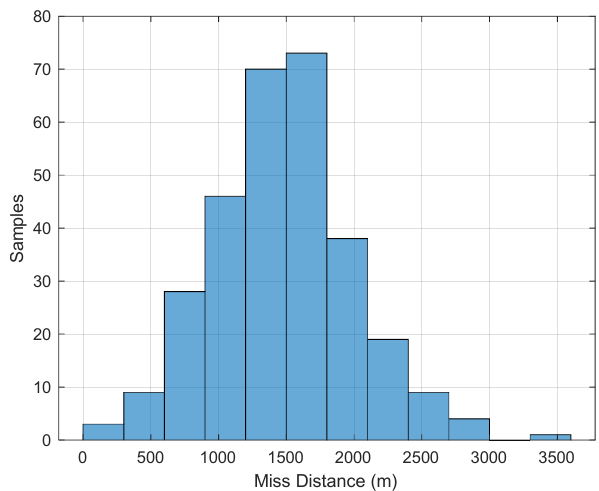
Figure 27. Unguided Rocket Histogram.